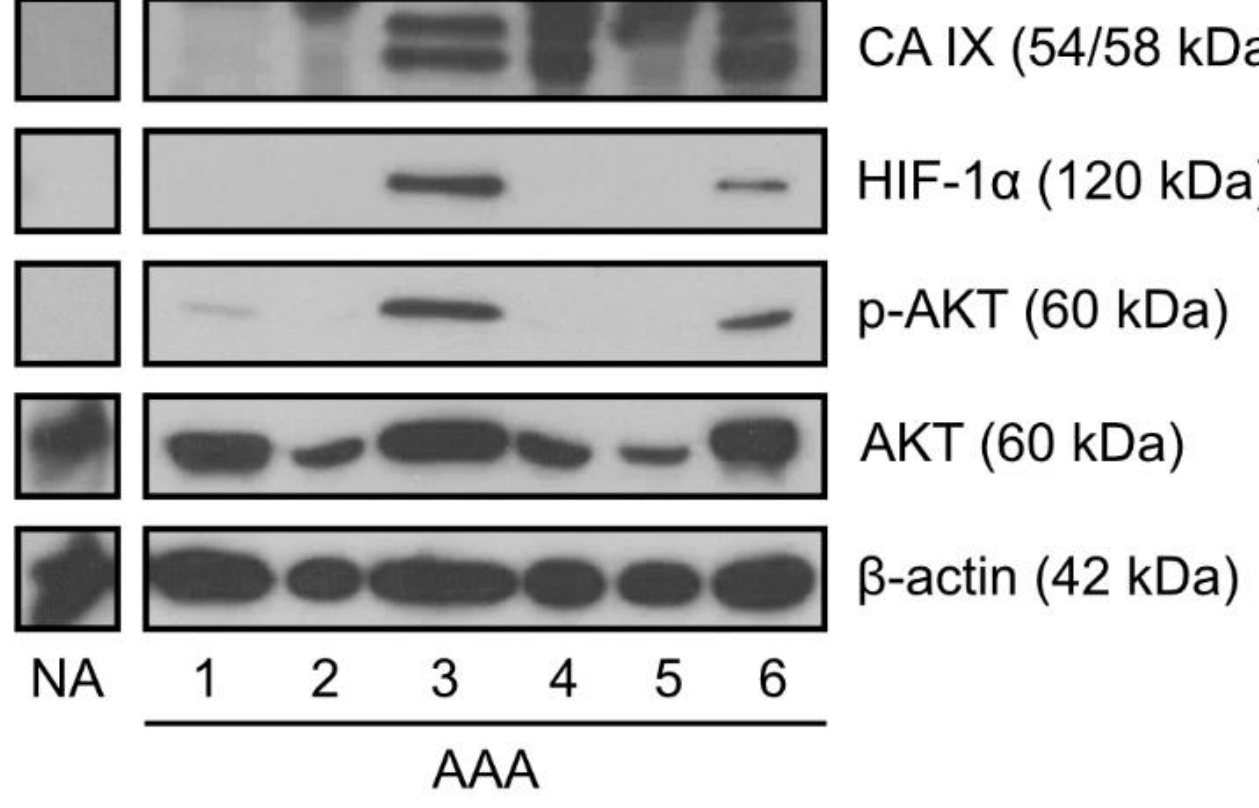
Figure 2. Representative western blots of HIF-1 α , p-AKT, and AKT expression in human AAA tissues. Protein levels were determined by western blot analysis of proteins extracted from human abdominal aortic aneurysms (AAA) and a pool of normal aortas (NA). Detection of β -actin served as a loading control.